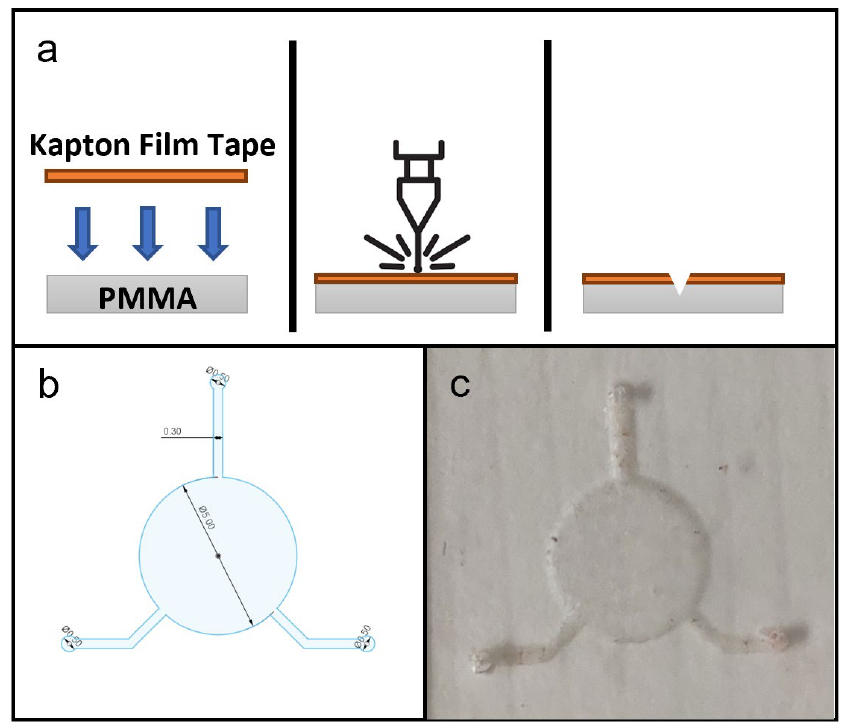
Figure 2. ( a ) Schematic diagram of fabrication microfluidic features on PDMS substrate, showing in cross-section the setup of materials, laser ablation process and microfluidic features on PDMS substrate. ( b ) CAD drawing of microfluidic design for this study. ( c ) Photograph of a produced PDMS microfluidic chip.